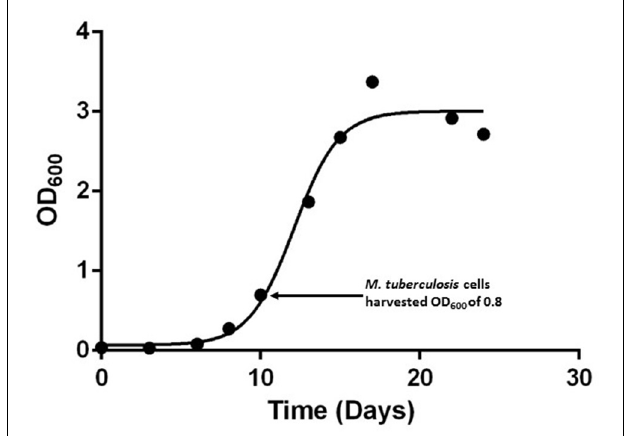
FIGURE 1 | Growth curves of hyper-virulent M. tuberculosis Beijing strain. Growth monitored over a 24 day period using OD 600 measurements in 7H9 Middlebrooks liquid media supplemented with dextrose and